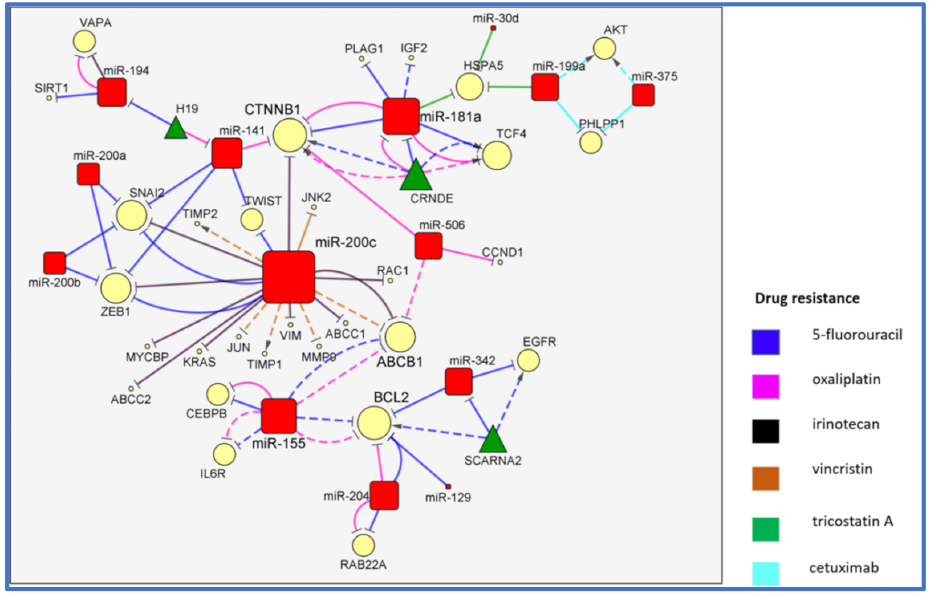
Figure 2. MiR-200s/miR-181a and their targets in CRC drug resistance. The miRNAs in the network are connected with a number of targets (direct or indirect) and are involved in the resistance to vincristine (VCR), irinotecan (CPT11), 5-fluorouracil (5-FU), oxaliplatin (L-OHP), trichostatin A (TSA) and cetuximab (CET). In detail, the overexpression of miR-200c leads to the direct suppression of c-Jun N-terminal kinase 2 ( JNK2 ) and indirectly to that of JUN , ATP-binding cassette subfamily B member 1 ( ABCB1 ) and matrix metallopeptidase 9 ( MMP9 ), leading, in turn, to the overexpression of TIMP metallopeptidase inhibitor 1 ( TIMP1 ) and TIMP2 in HCT8 cells treated with VCR [3]. The ABCB1 molecular transporter is also an indirect target of miR-506, a negative regulator of CTNNB1 and cyclin D1 ( CCND1 ), and promotes L-OHP sensitivity in colon cancer after forced expression [4]. Juang et al. confirmed that miR-200c acted as promoter of CPT11 sensitivity in CRC cells after encapsulation in solid liposomes by suppressing the RAS/CTNNB1/ZEB pathway [5]. Consistently, the loss of miR-200 and miR-141 were related to the overexpression of the zinc finger E-box-binding homeobox 1 ( ZEB1 ) and snail family transcriptional repressor 2 ( SNAI2 ) (targeted by miR-200a, miR-200b and miR-141) and twist family bHLH transcription factors ( TWIST ) (targeted by miR-200c and